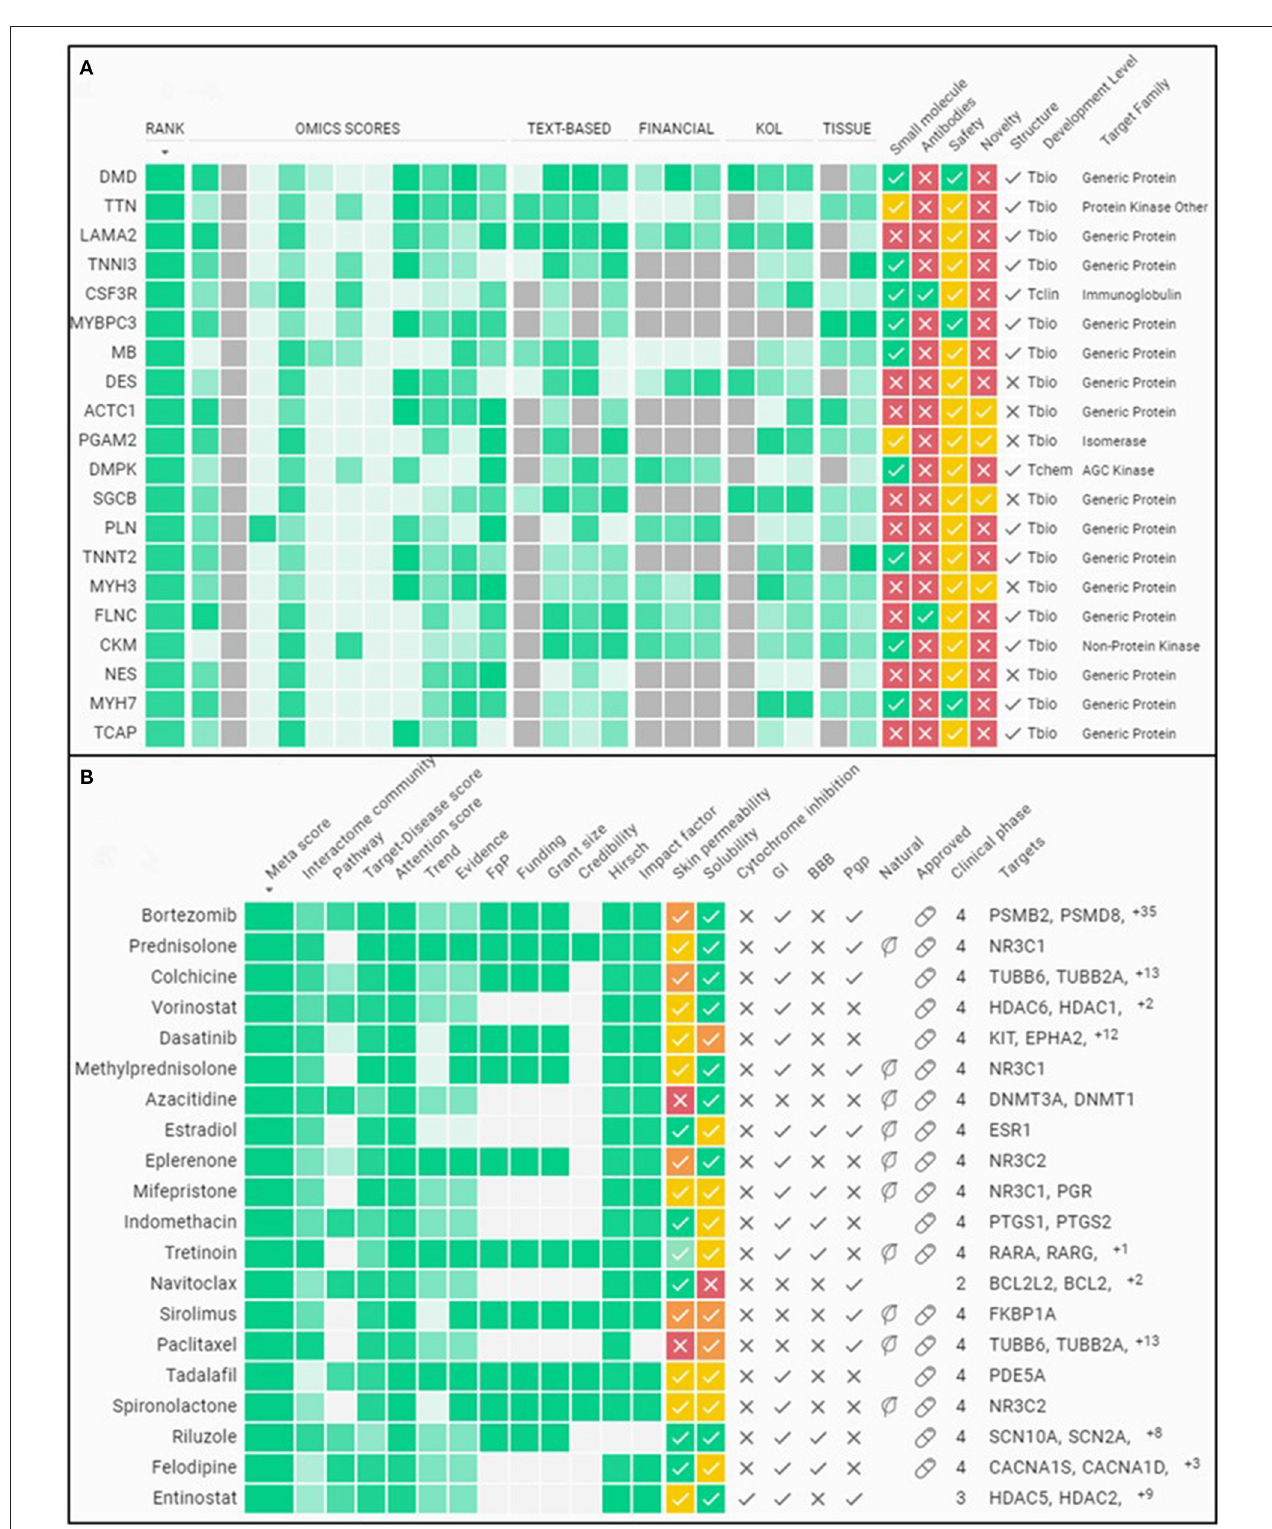
FIGURE 2 | Sample meta-analysis from an A.I. driven therapeutics platform. (A) Summary of some of the top gene targets associated to DMD. (B) Summary of some of the top compounds associated to DMD for therapy. The evidence for classifying these molecules as the top targets is gleaned from various public databases plus the funding and publications landscape using PandaOmics (http://pandaomics.com/).